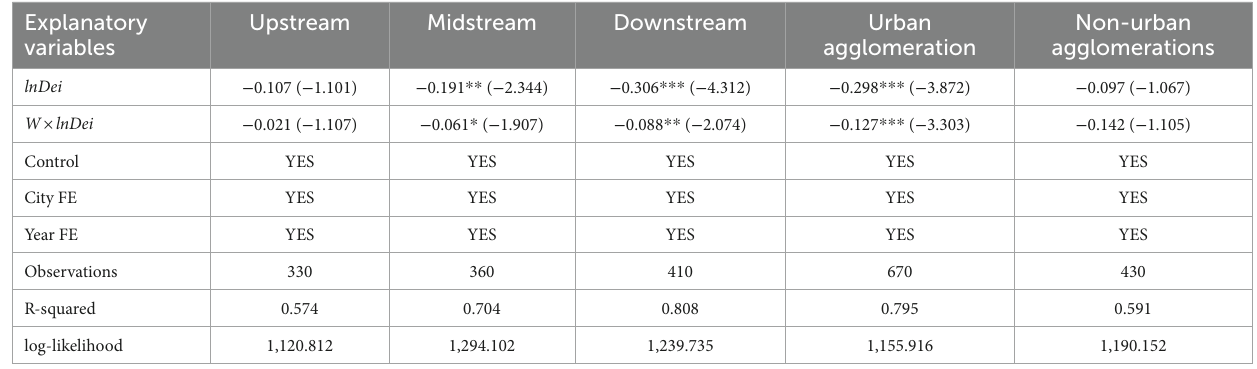
TABLE 9 Regression results of the spatial heterogeneity